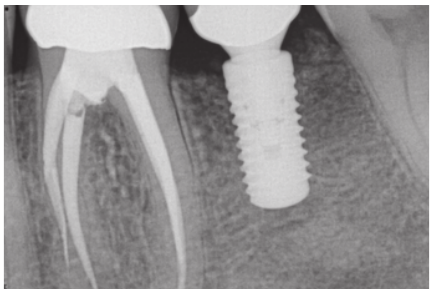
Figure 19: The implant was restored following a healing period of 6 months. The patient has been followed for 1 year